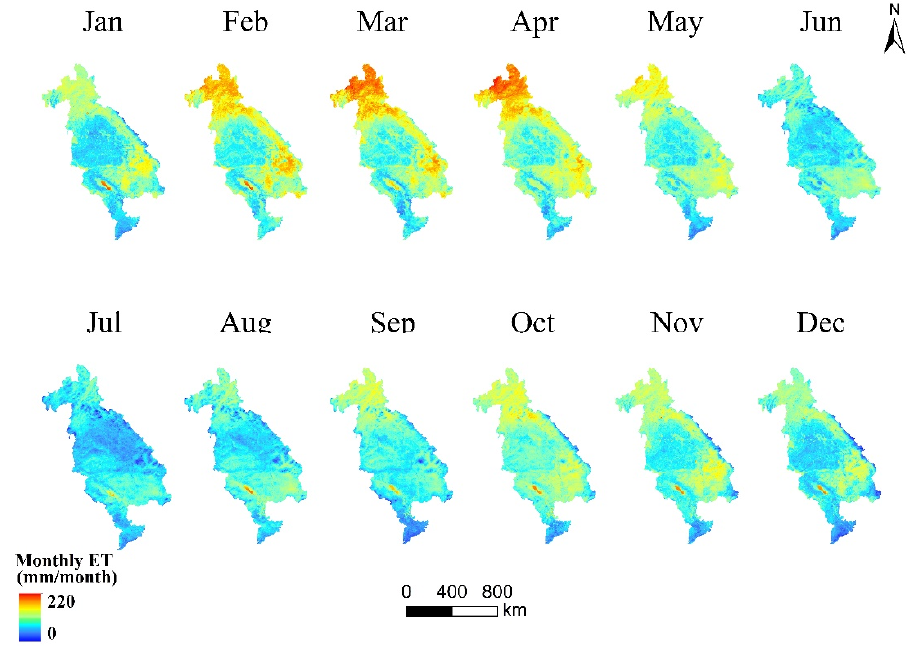
Figure 6. The spatial distribution of average annual ET from 2008 to 2017 in the Lower Mekong River basin.